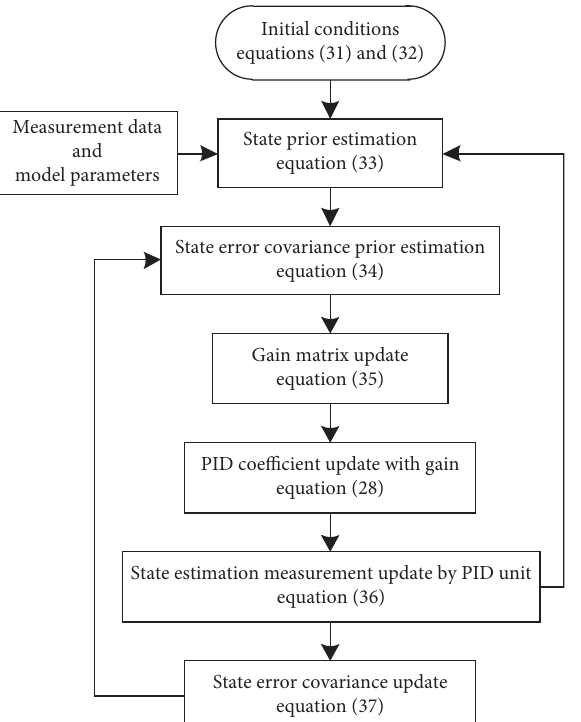
Figure 4: The flowchart of AEKF-PID estimator for LIB SOC.